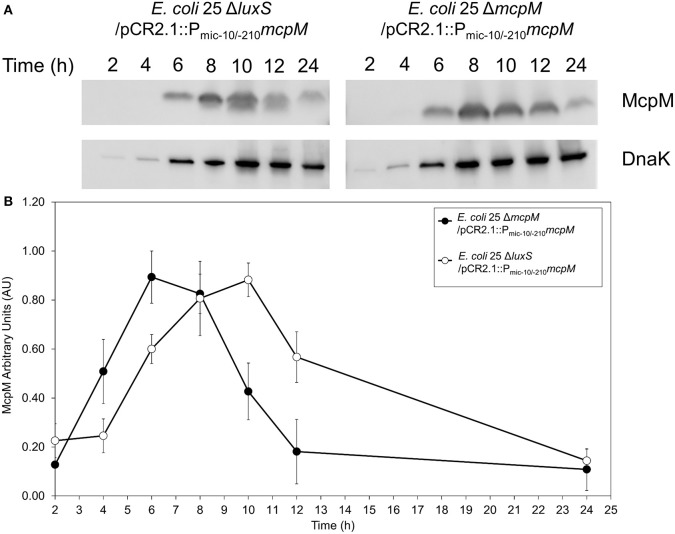
E. coli 25 ΔluxS mutant causes delay in McpM production. (A) Western blot of McpM. Whole-cell lysate samples from E. coli 25 ΔmcpM/pCR2.1::Pmic−10/−210mcpM and E. coli 25 ΔluxS/pCR2.1::Pmic−10/−210mcpM complemented strains were collected for every 2 h from 2 to 12 h, and 24 h. Endogenous DnaK served as a loading control. (B) Western blot densitometry analysis of McpM. Whole-cell lysate samples from E. coli 25 ΔmcpM/pCR2.1::Pmic−10/−210mcpM (black circle) and E. coli 25 ΔluxS/pCR2.1::Pmic−10/−210mcpM (white circle) complemented strains were collected for every 2 h from 2 to 12 h, and 24 h. Endogenous DnaK served as a loading control. Normalization of the McpM against DnaK are represented by arbitrary unit (AU) over 24 h. Error bars = SEM; three independent experiments.